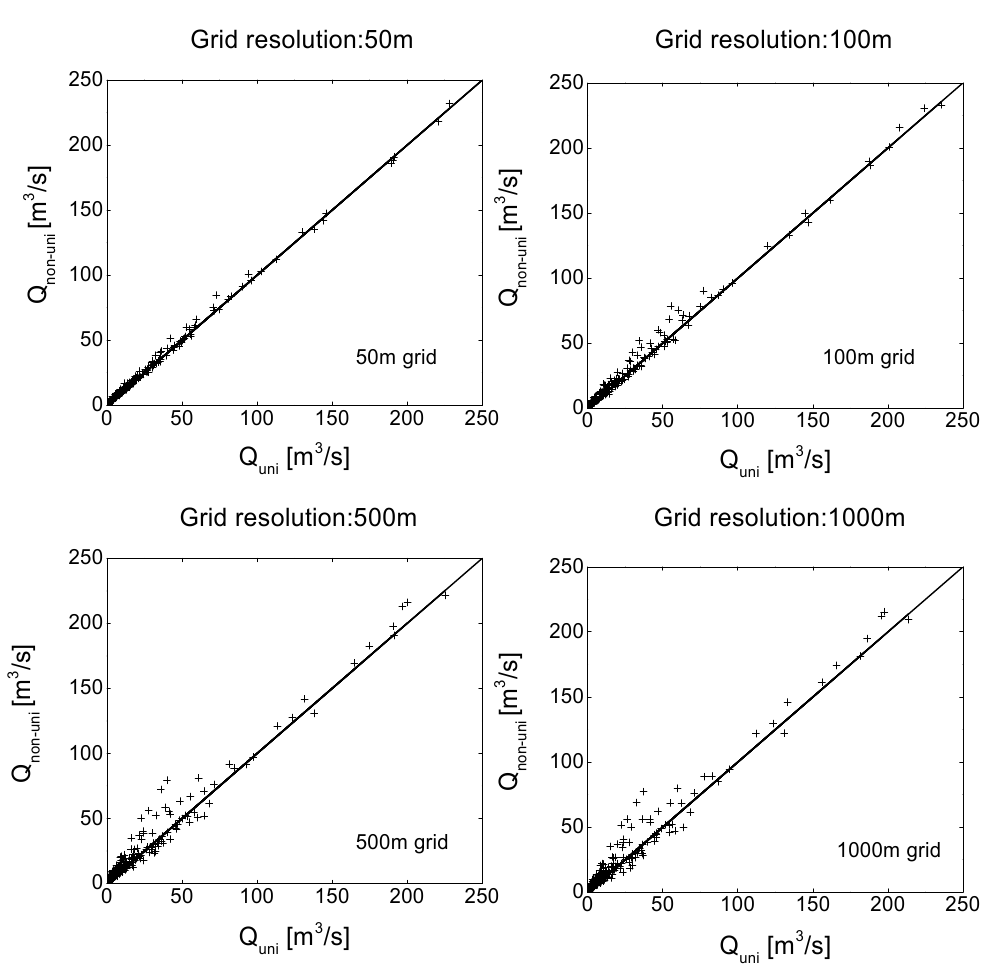
Figure 7. Discharge from the original Grid-Xinanjiang model ( Q uni ) versus runoff after incorporating the subgrid variability ( Q non-uni